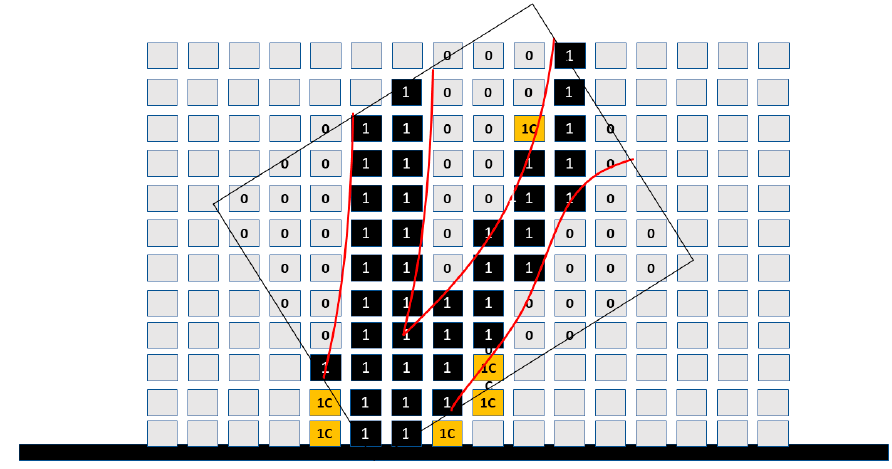
Figure 10. Final shape of the part’s